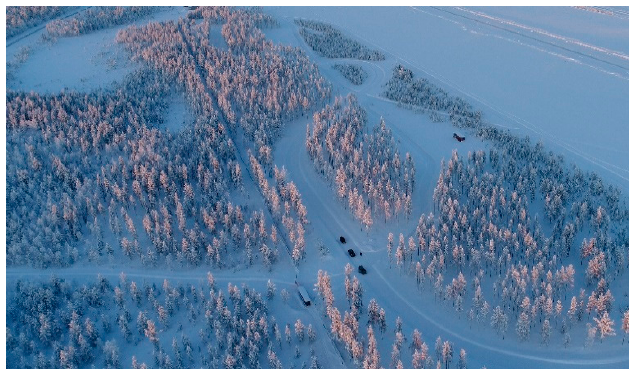
Figure 1. Heterogeneous vehicular networking test-track in Sodankylä, Finland